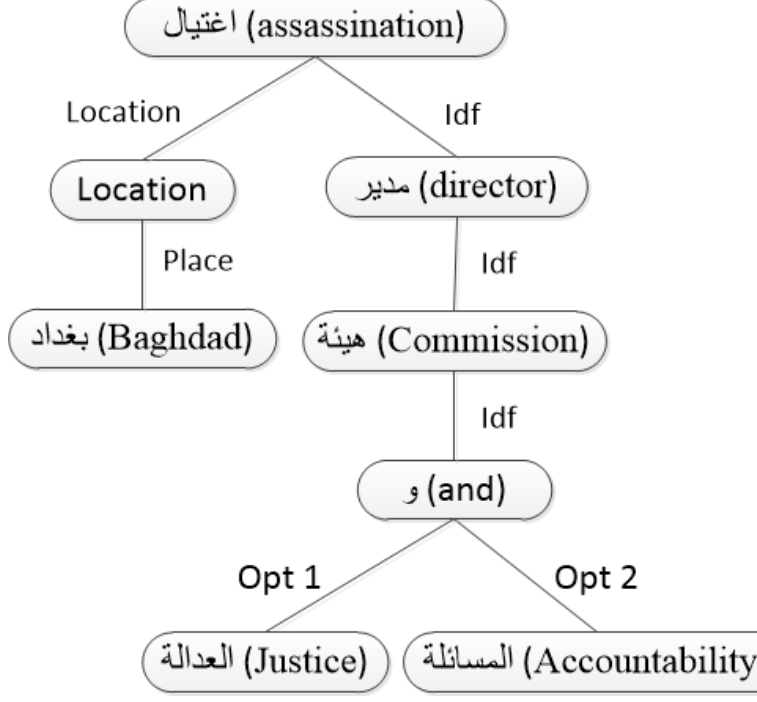
Figure A1. Semantic representation sample number